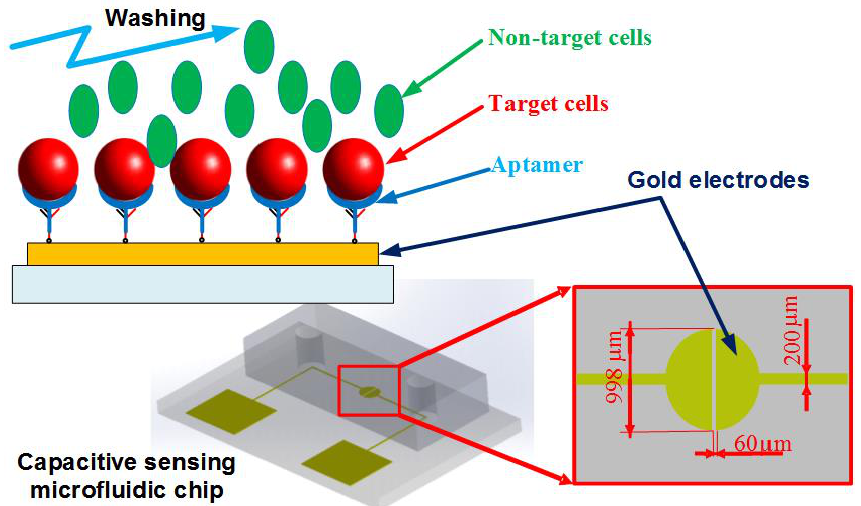
Figure 1. Schematic of the microfluidic chip. The aptamer-modified gold electrodes are utilized to capture the target cells, while the non-target cells are washed out of the channel. The impedance measurement could be performed within the chip to recognize the presence of the cells.